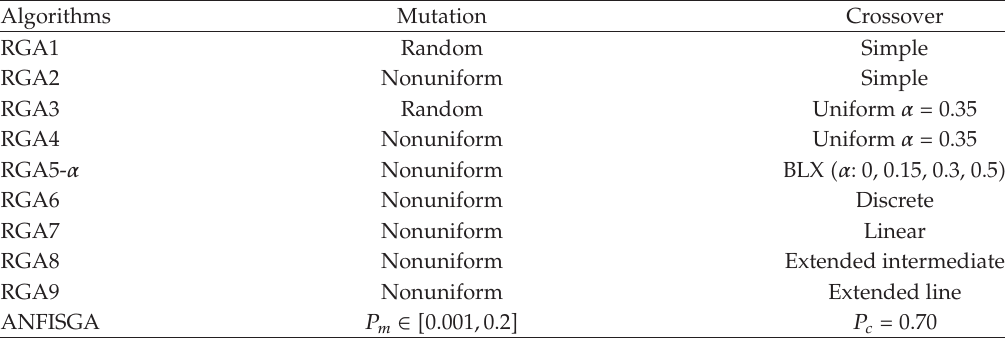
Table 2: Real Coded Genetic Algorithms (cid:2) RGA (cid:3) (cid:4) 14 (cid:5) .